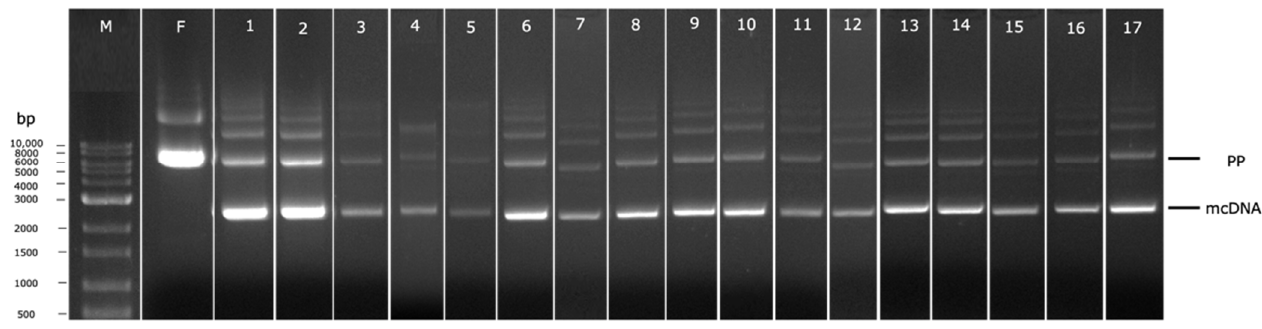
Figure 6. Analysis of PP recombination into mcDNA by agarose gel electrophoresis. M–molecular weight marker. F-Fermentation at 42 °C. Numbers 1–17 corresponds to each condition generated by DoE, as indicated in Table 1.